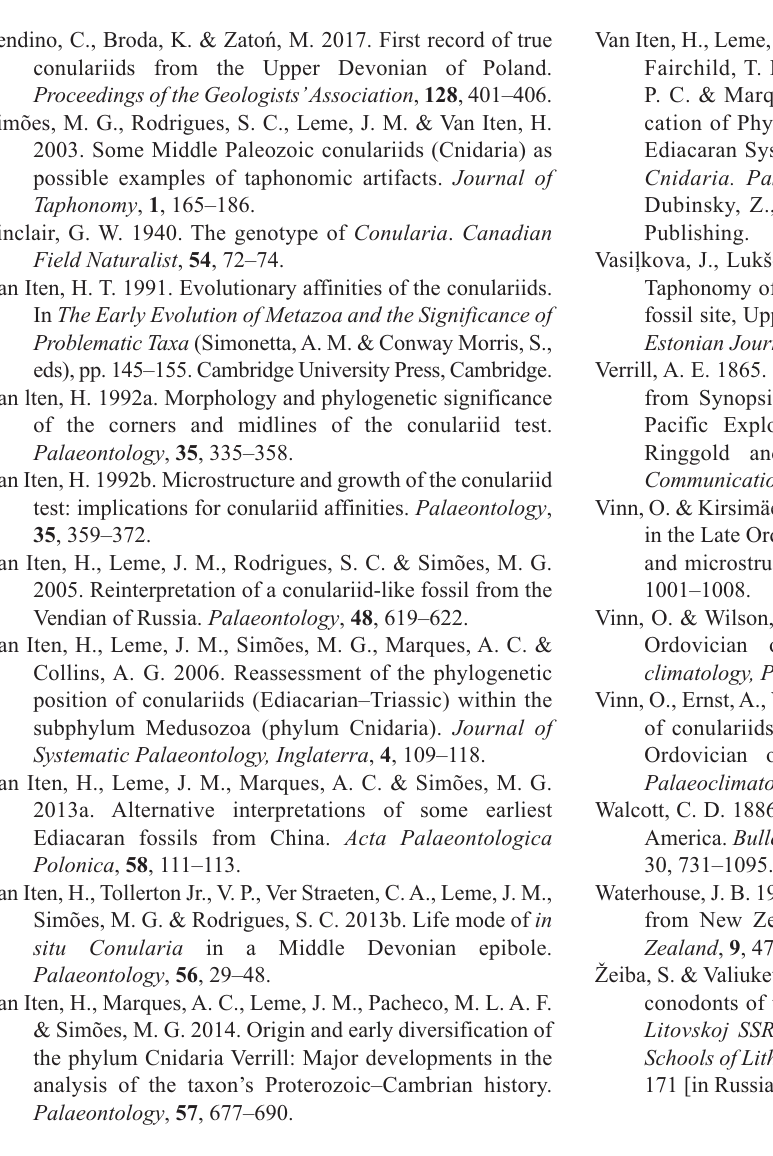
Konulariidide esmaleid Ülem­Devoni Tērvete kihistust Lätis Ervīns Lukševičs